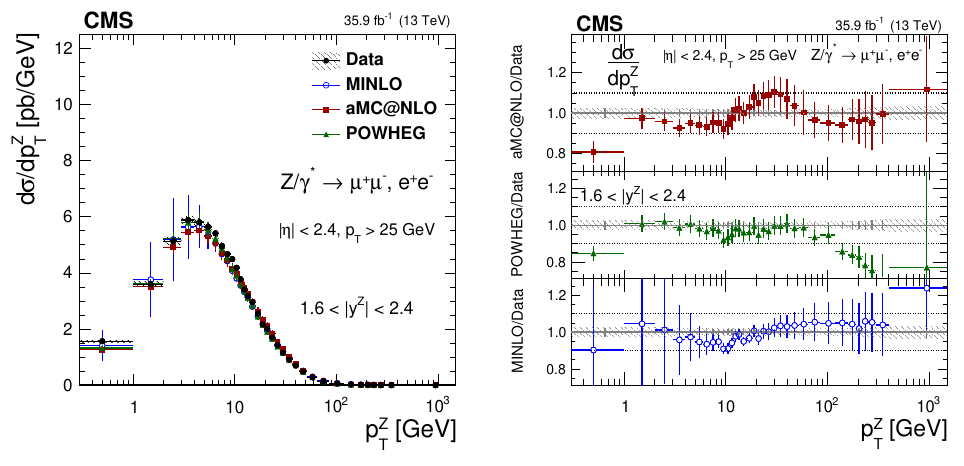
Figure 13 . The measured absolute cross sections (left) in bins of p Z for the 1 : 6 < j y Z j < 2 : 4 region. T The ratios of the predictions to the data are also shown (right). The shaded bands around the data points (black) correspond to the total experimental uncertainty. The measurement is compared to the predictions with MadGraph 5 a mc@nlo (square red markers), powheg (green triangles), and powheg - MINLO (blue circles). The error bands around the predictions correspond to the combined statistical, PDF, and scale